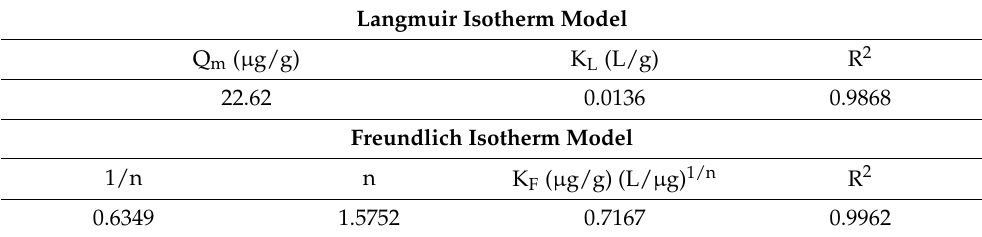
Table 1. Constants of Langmuir and Freundlich isotherm model for the adsorption of As(III) onto the combination of GO (0.2 g/L) and GFH (0.1 g/L), pH 7.0 ± 0.1, T = 298 K, contact time 24 h, in deionized